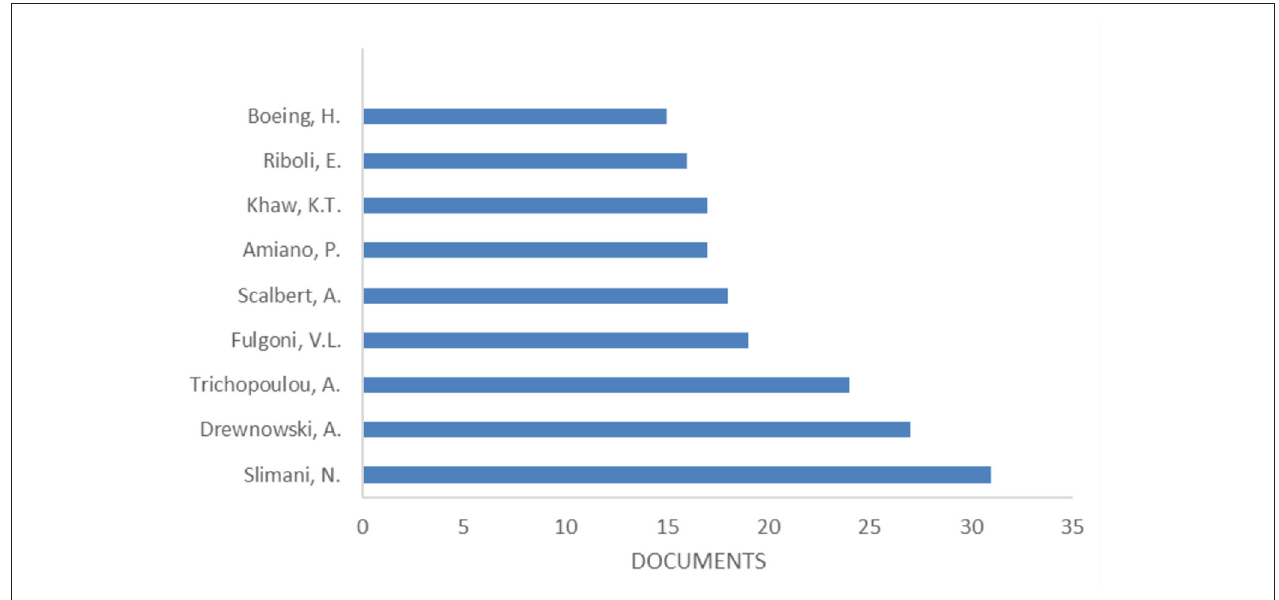
FIGURE 3 | Most productive Authors. Based on data from Scopus.